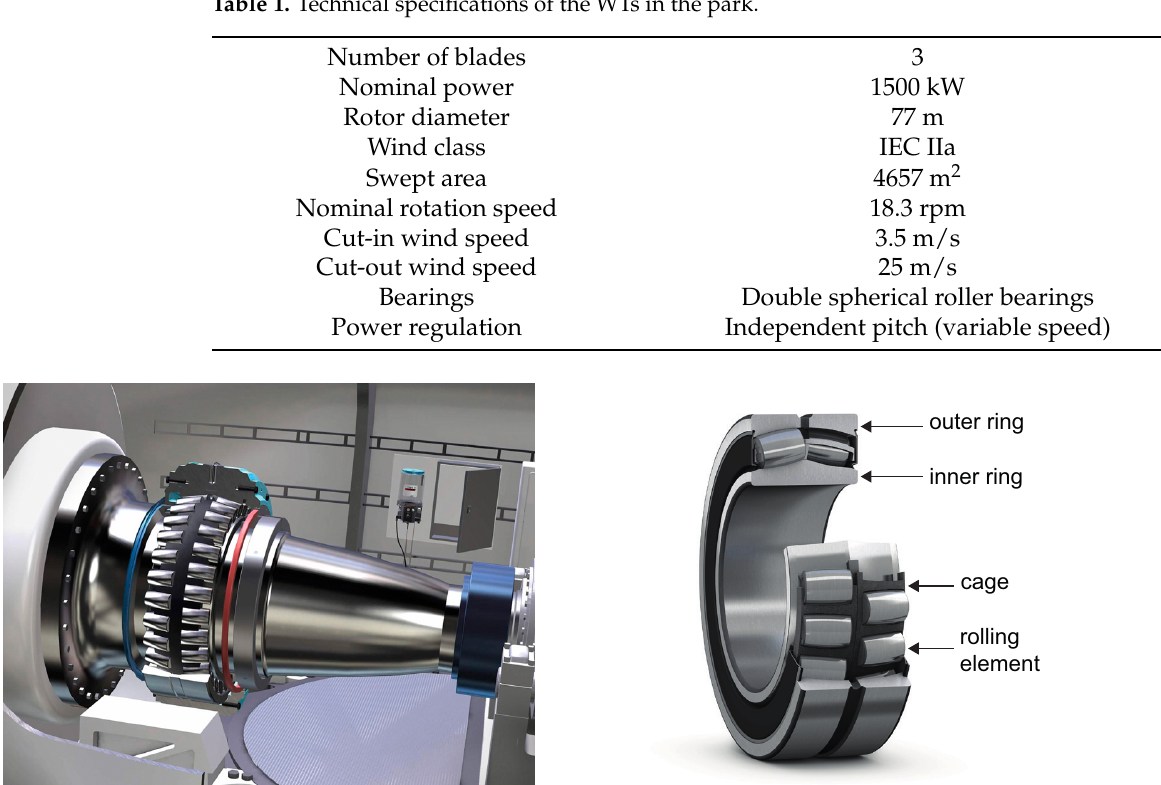
Figure 2. Spherical roller main bearing used in WTs. Courtesy of